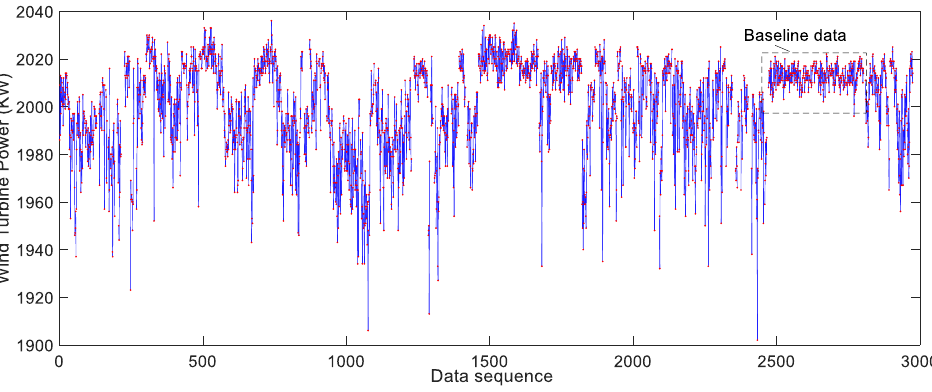
Figure 11. Power time series curve of T22 in the rated power output region (RPOR).